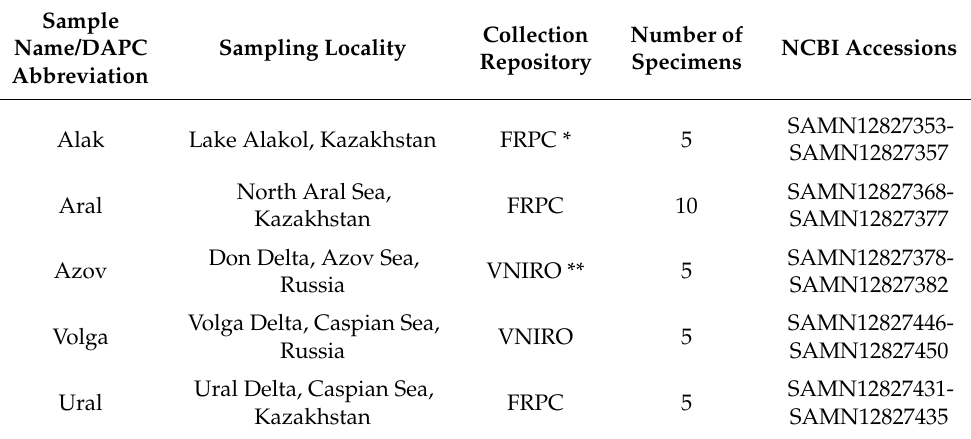
Table 1. Common carp specimens used in this study, tissue collection repository, and Genbank ac-